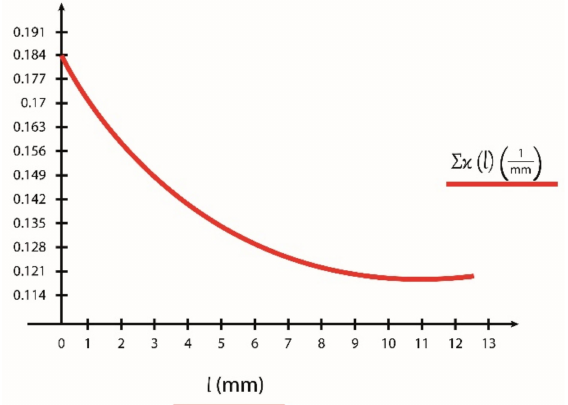
Figure 3. The change of the instantaneous sum curve Σ κ ( l ) , along the path of contact.